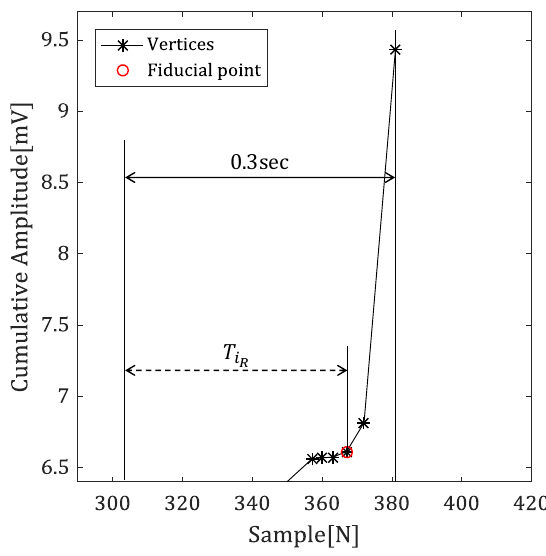
Figure 7. The time difference between the reference point and vertex in the cumulative